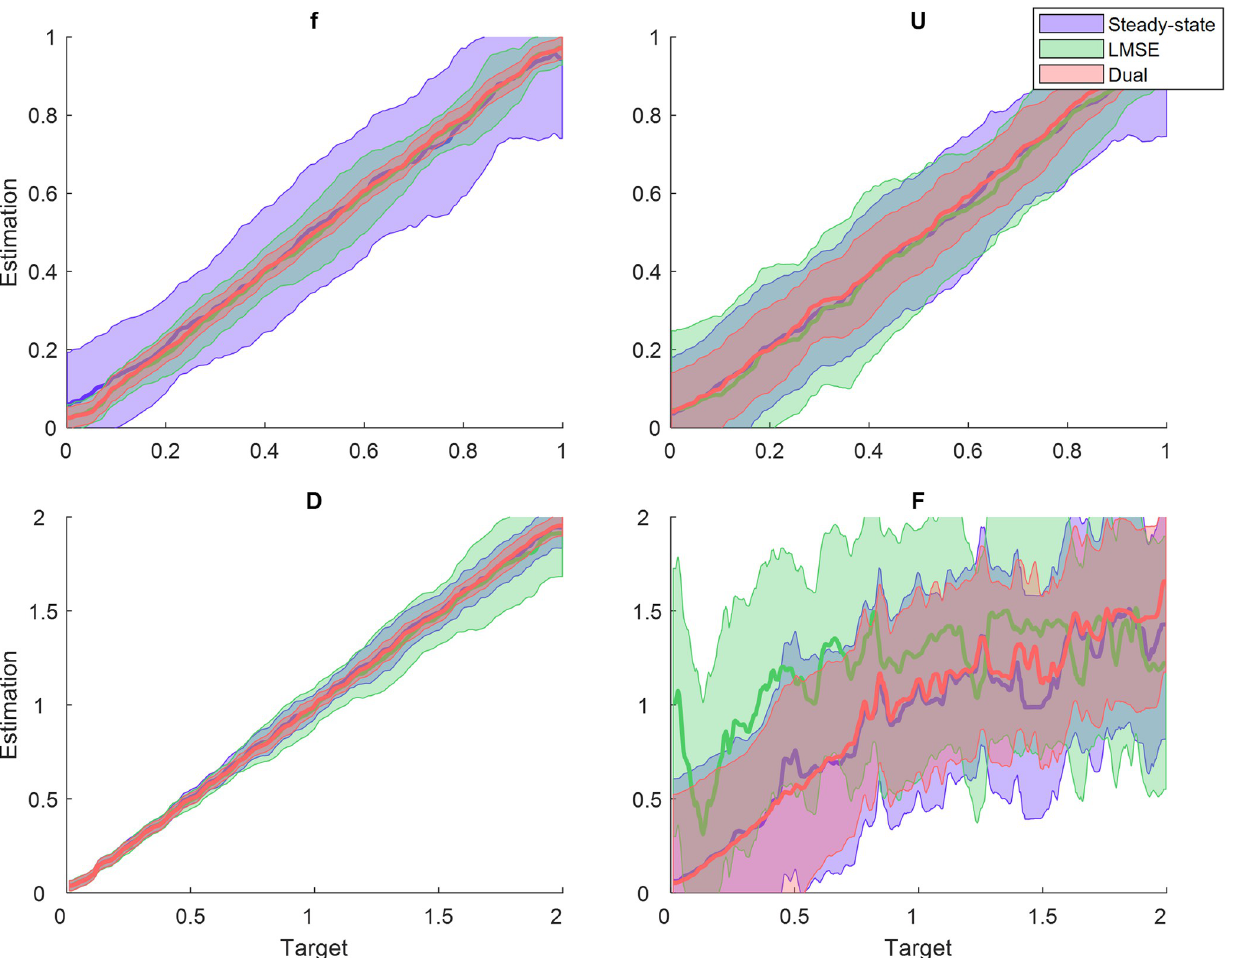
Fig 5. Comparison between the performance of the steady-state-based, the conventional LMSE, and the dual optimization approaches in estimating parameters of the TM model. Green, blue, and red colors represent the steady-state-based, the conventional LMSE, and dual optimization approaches, respectively. The thick lines represent smoothed moving average (Hann window) of the estimation. The shaded areas show the 68.2% confidence interval of the estimated values. As the estimation regression line gets closer to the y = x line the correlation of the estimation and true values increases, and the estimation is more